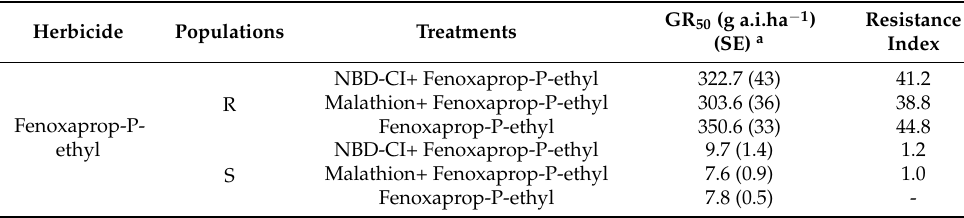
Table 1. Effects of the cytochrome P450 inhibitor (malathion) and GST inhibitor (NBD-Cl) on Alopecu- rus japonicus dose response to fenoxaprop-P-ethyl.